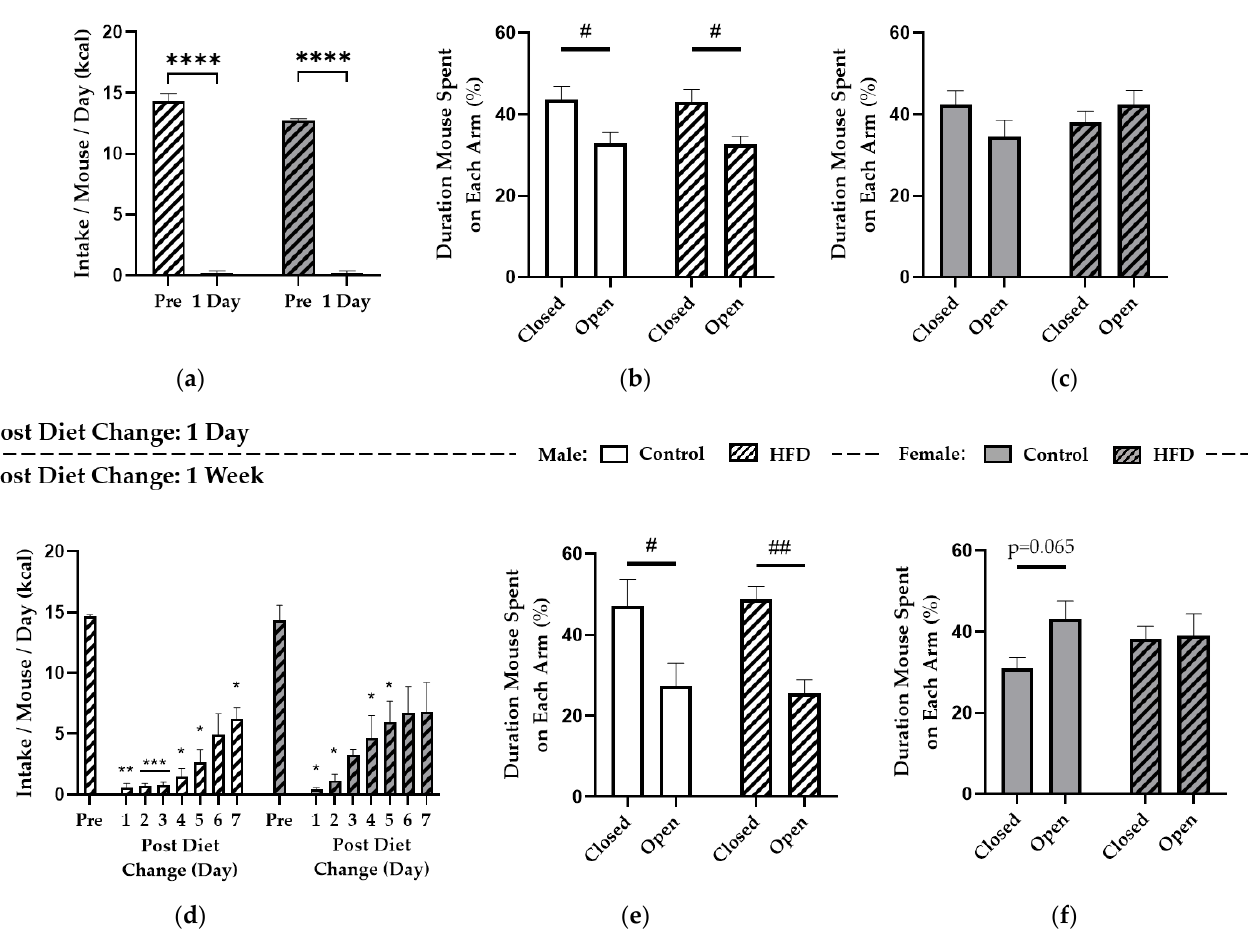
Figure 3. Effect of HFD Replacement on Control Diet Consumption in HF-Fed Mice and Anxiety-Like Behaviors Determined by the Elevated Plus-Maze (EPM). One day after HFD replacement, HF-fed males and females almost completely restricted kcal intake ( a ). EPM results show the total percent duration spent on the closed versus open arms for males ( b ) and females ( c ) one day after HFD replacement or pair-feeding in controls. Intake for HF-fed males and females is also shown over one week of HFD replacement ( d ) with EPM results displayed as percent duration on closed versus open arms for males ( e ) and females ( f ). * denotes a significant difference between kcal intake in HF-fed mice before (Pre) and each day after HFD replacement; # denotes significant differences between time spent on the closed versus open arms of the EPM. *, p < 0.05; **, p < 0.01; ***, p < 0.001; ****, p < 0.0001; #, p < 0.05; ##, p < 0.01.